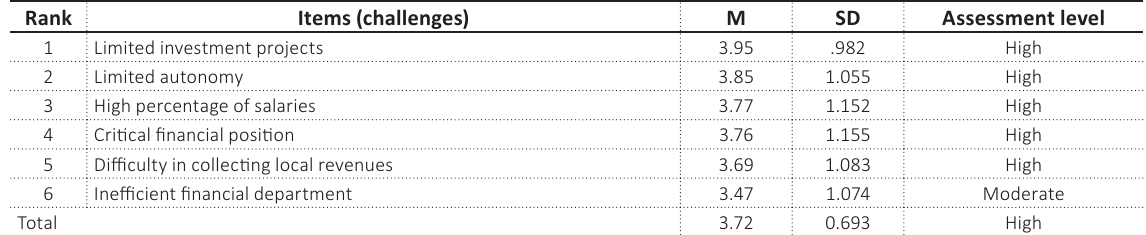
Table 4. Respondents’ assessment of the challenges of financial viability facing local government